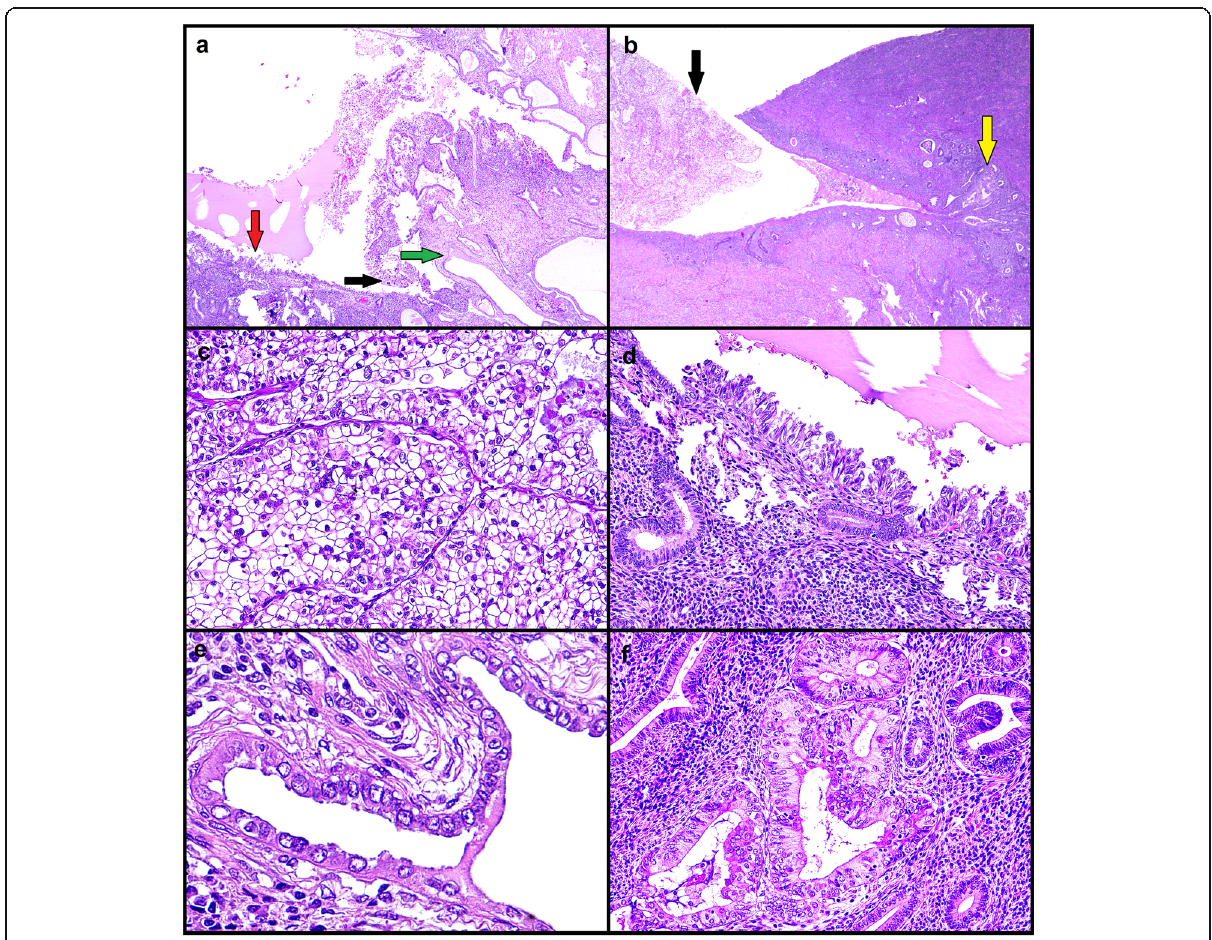
Fig. 3 Case 2. Hematoxylin-eosin findings. Panoramic view ( a magnification 40X) ( b magnification 20X) of invasive clear cell carcinoma (black arrow) and metaplastic-like putative precursor (green arrow) in en endometrial polyp, with CC-EIC (red arrow) and AEH/EIN-like putative precursor (yellow arrow) in the surrounding endometrium. Details of invasive clear cell carcinoma ( c magnification 200X), CC-EIC ( d magnification 200X), metaplastic-like putative low-grade precursor ( e magnification 400X), AEH/EIN-like putative low-grade precursor ( f magnification